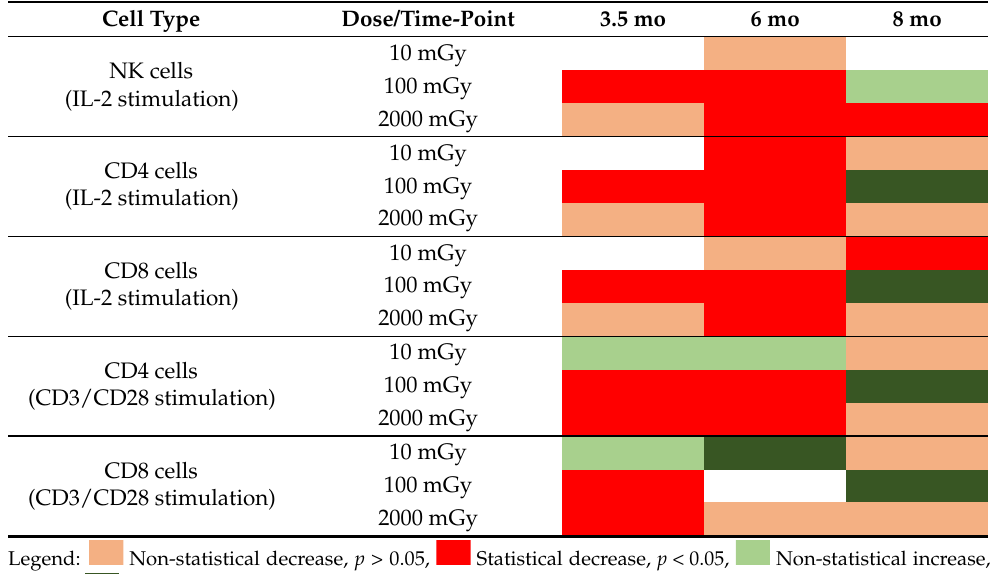
Table 2. Summary of LDR-induced immune cell proliferation.